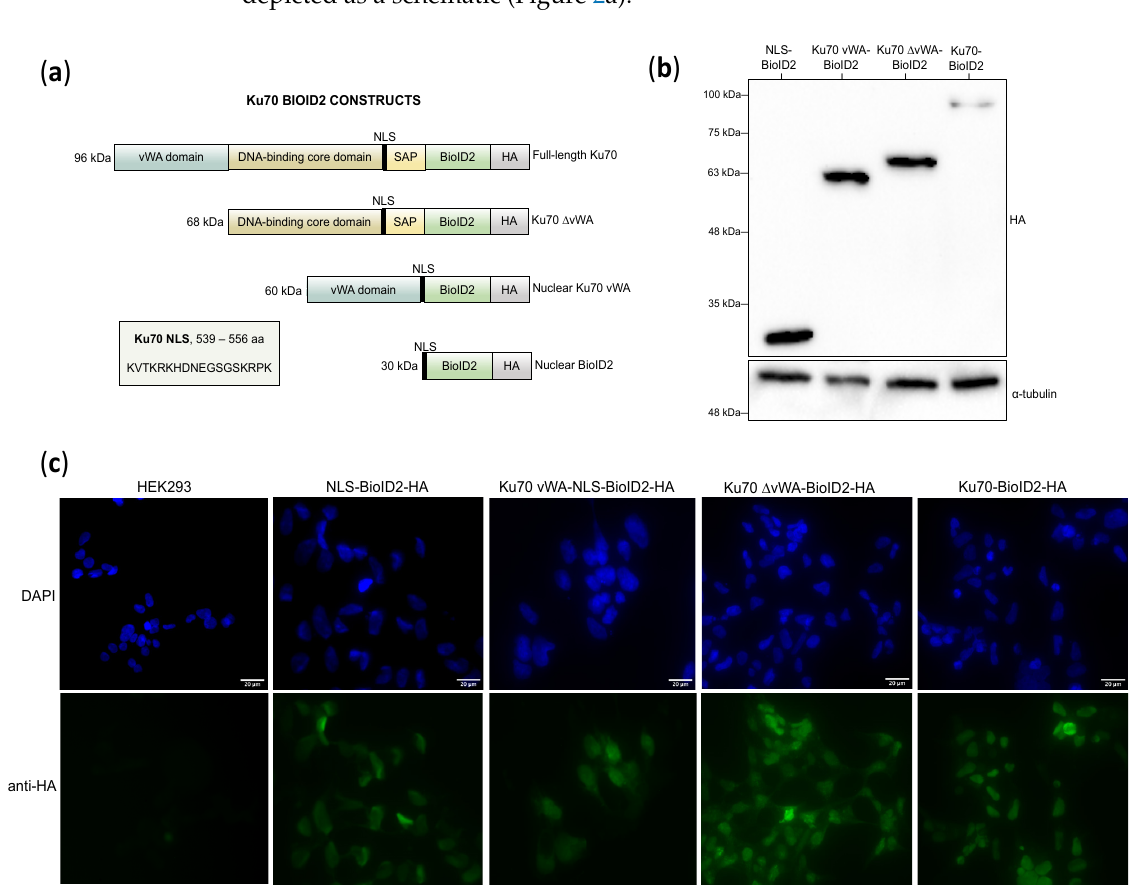
Figure 2. Testing Ku70-BioID2 constructs in HEK293 stable cell lines for expression and cellular localization. Note that all Ku70-BioID2 constructs are HA-tagged at their C-terminus: ( a ) Schematic diagram of Ku70-BioID2 constructs where NLS denotes nuclear localization signal and SAP denotes SAF-A/B, Acinus, and PIAS motifs domain; ( b ) Testing the expression of pooled, polyclonal HEK293 stable cell lines by Western blotting of 50 μ g of whole cell extracts; ( c ) Indirect immunofluorescence microscopy of Ku70-BioID2 stable cell lines. Images taken at 40× magnification with white bar denoting 20 μ m.